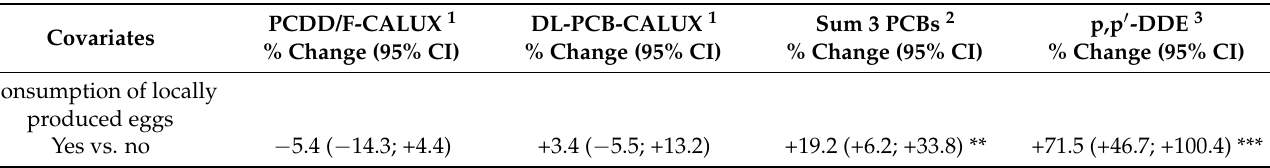
Table 4. Multiple linear regression results on consumption of locally produced food (% change compared to reference category and 95% CI) for PCDD/F-CALUX, dioxin-like PCBs-CALUX, sum 3 PCBs (138 + 154 + 180) and p,p (cid:48) -DDE in serum (ng/L) for 14–15 year-old adolescents of the FLEHS II study population in the ICS Menen and the Flemish reference group combined ( n = 409).